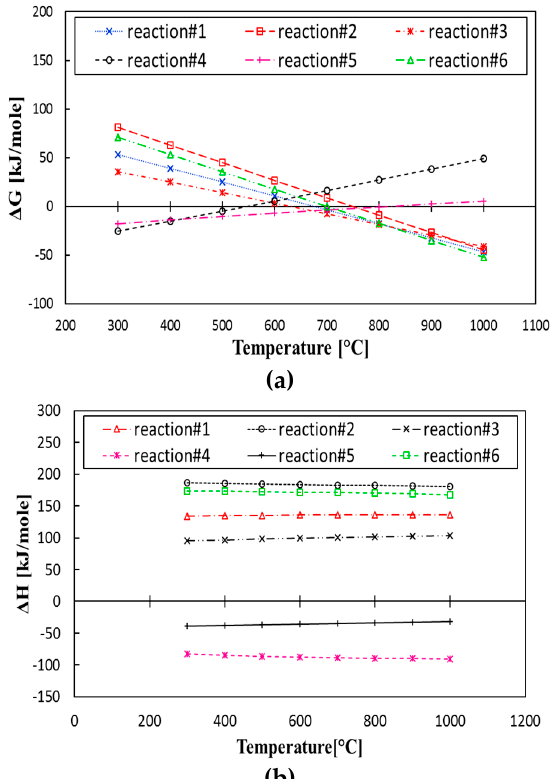
Figure 4. Dependence on temperature of the Gibbs free energy and enthalpy of the reaction with temperature. (a) Variation of the change in the Gibbs free energy of reactions with temperature for the reactions given in Table 1 and (b) variation of the enthalpy of the reaction with temperature for the reactions given in Table